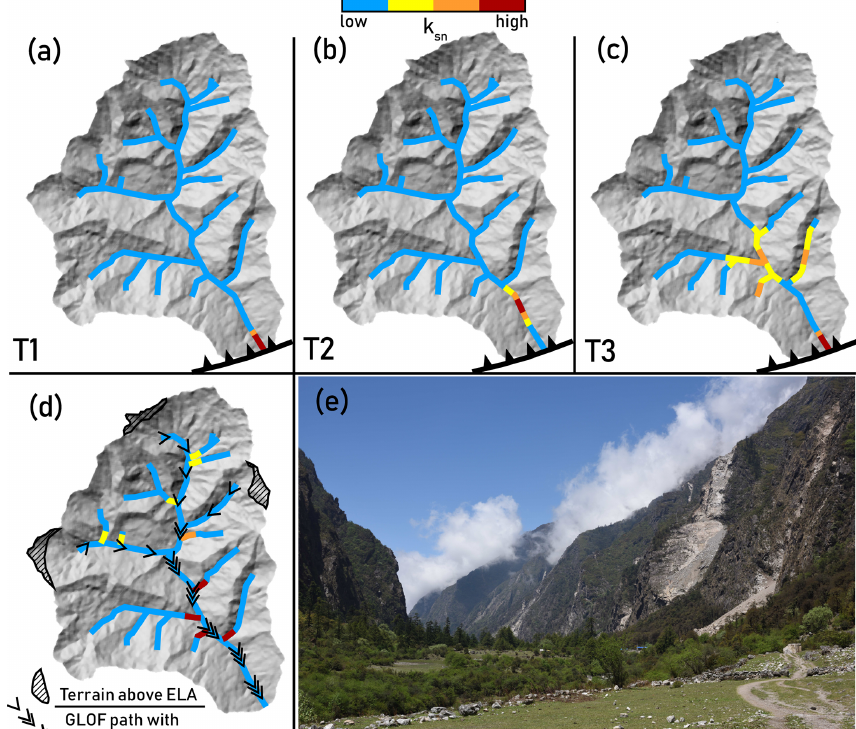
Figure 2. (a) Schematic of predicted k sn patterns arising from erosion driven by upstream knickpoint migration resulting from base level fall, including knickpoint diffusion described in alluvial and bedrock-alluvial channels (Rosenbloom and Anderson, 1994). Panels (a–c) represent time steps showing the evolution of k sn patterns following a base level fall initiating at the thrust fault at the outlet of the catchment (panels a–c reflect temporal progression). In (c) , a second base level fall has initiated. (d) Schematic of k sn patterns we hypothesize to arise from erosion driven by GLOFs originating from the high-elevation regions shown as terrain above ELA. Steepened reaches formed near confluences may migrate upstream, steepening the basin at large. Our aim in illustrating the simple scenario shown in panels (a–c) is not to suggest it as a plausible representation of the tectonic geomorphology of the Himalaya but instead to contrast the end-member expectations from erosion purely driven by changes in base level versus the conceptual model we propose for glacial lake outburst flood (GLOF)-driven erosion, in panel (d) – while recognizing that actual erosion in Himalayan river valleys will involve a collaboration between these end- member scenarios. (e) Photograph from Langtang Valley, Nepal, showing steep inner valley walls and steep tributary catchments entering the trunk valley 1km below the lowest identified glacial surfaces. Photo location is 28.200 ◦ N, 85.460 ◦ E. Photo courtesy of William Medwedeff.